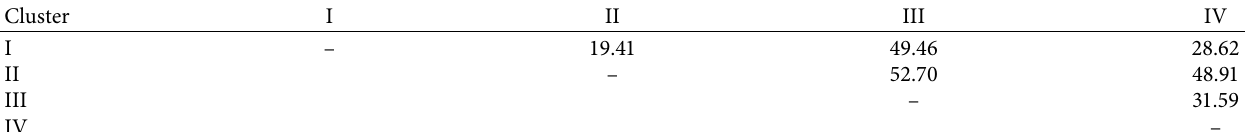
Table 8: Mahalanobis distance between